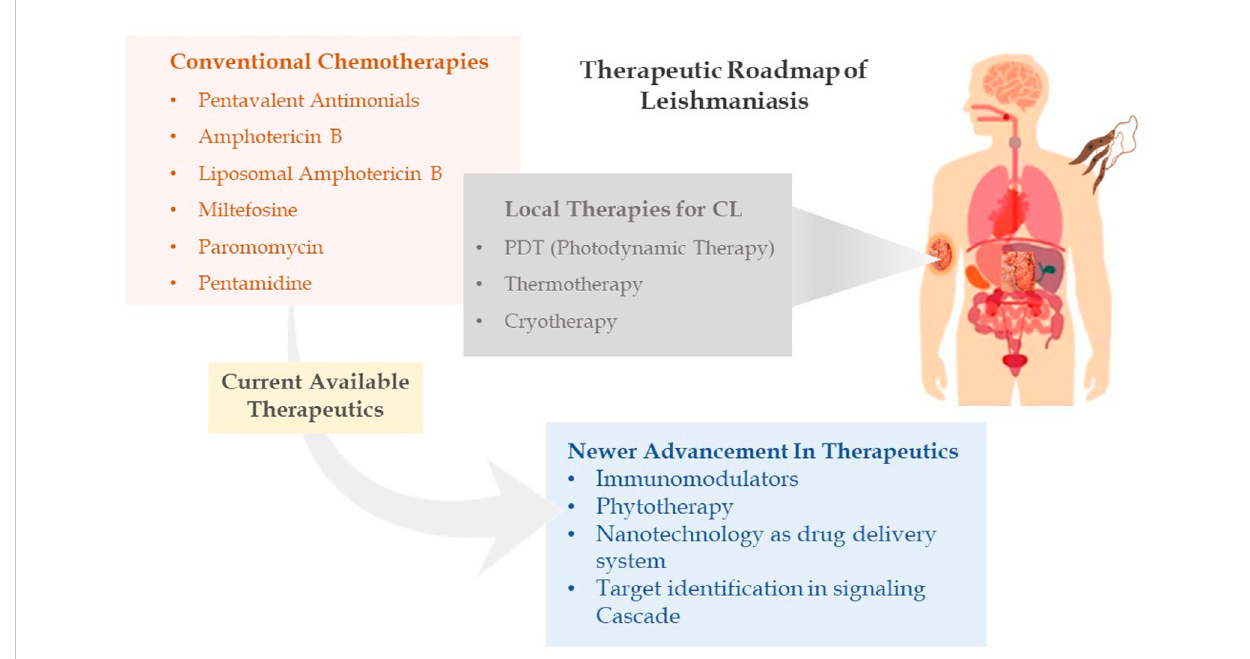
FIGURE 2 Therapeutic roadmap of leishmaniasis illustrating conventional chemotherapies, local therapies, and newer advancement in therapeutics.